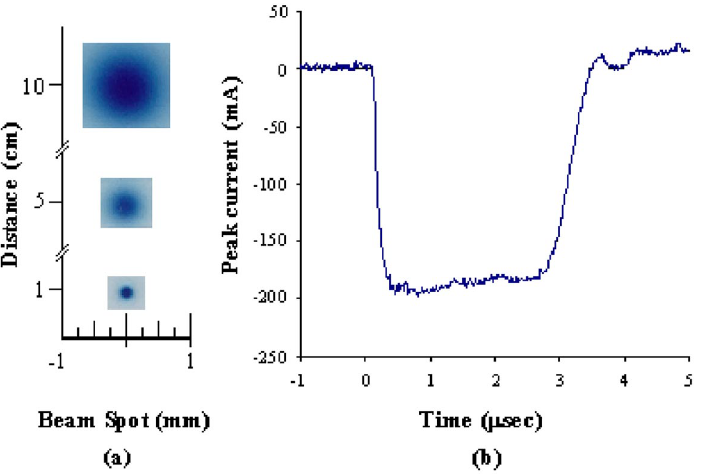
FIG. 8. (Color) Electron beam